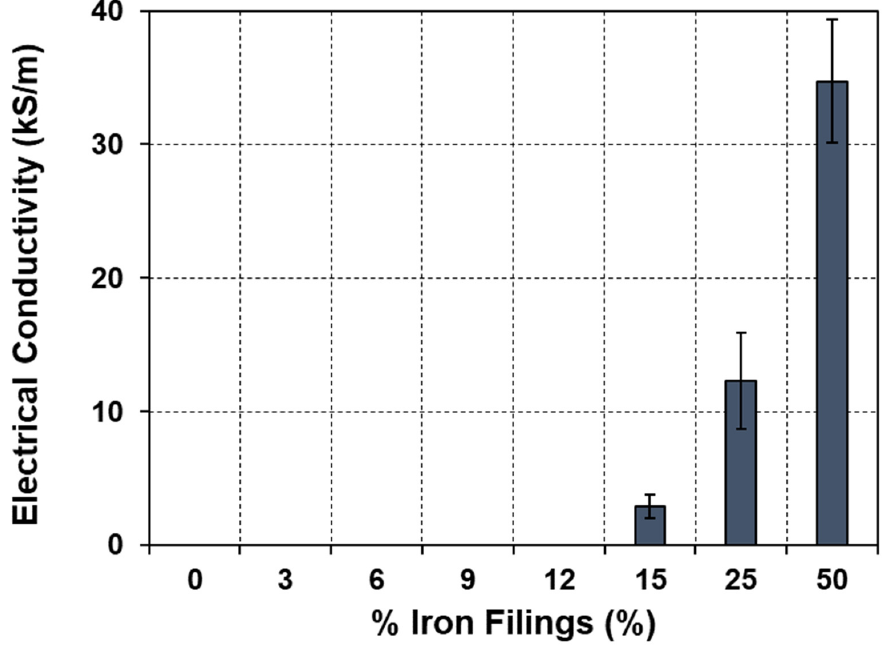
Figure 7. The electrical conductivity of the GFRE upon the addition of different WIF amounts.